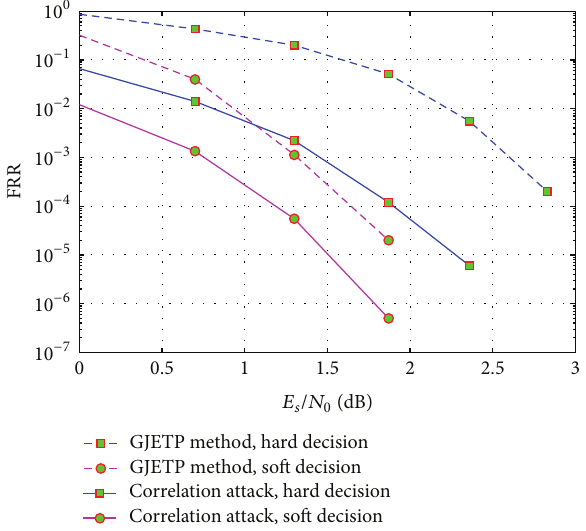
Figure 7: Comparison of GJETP method and correlation